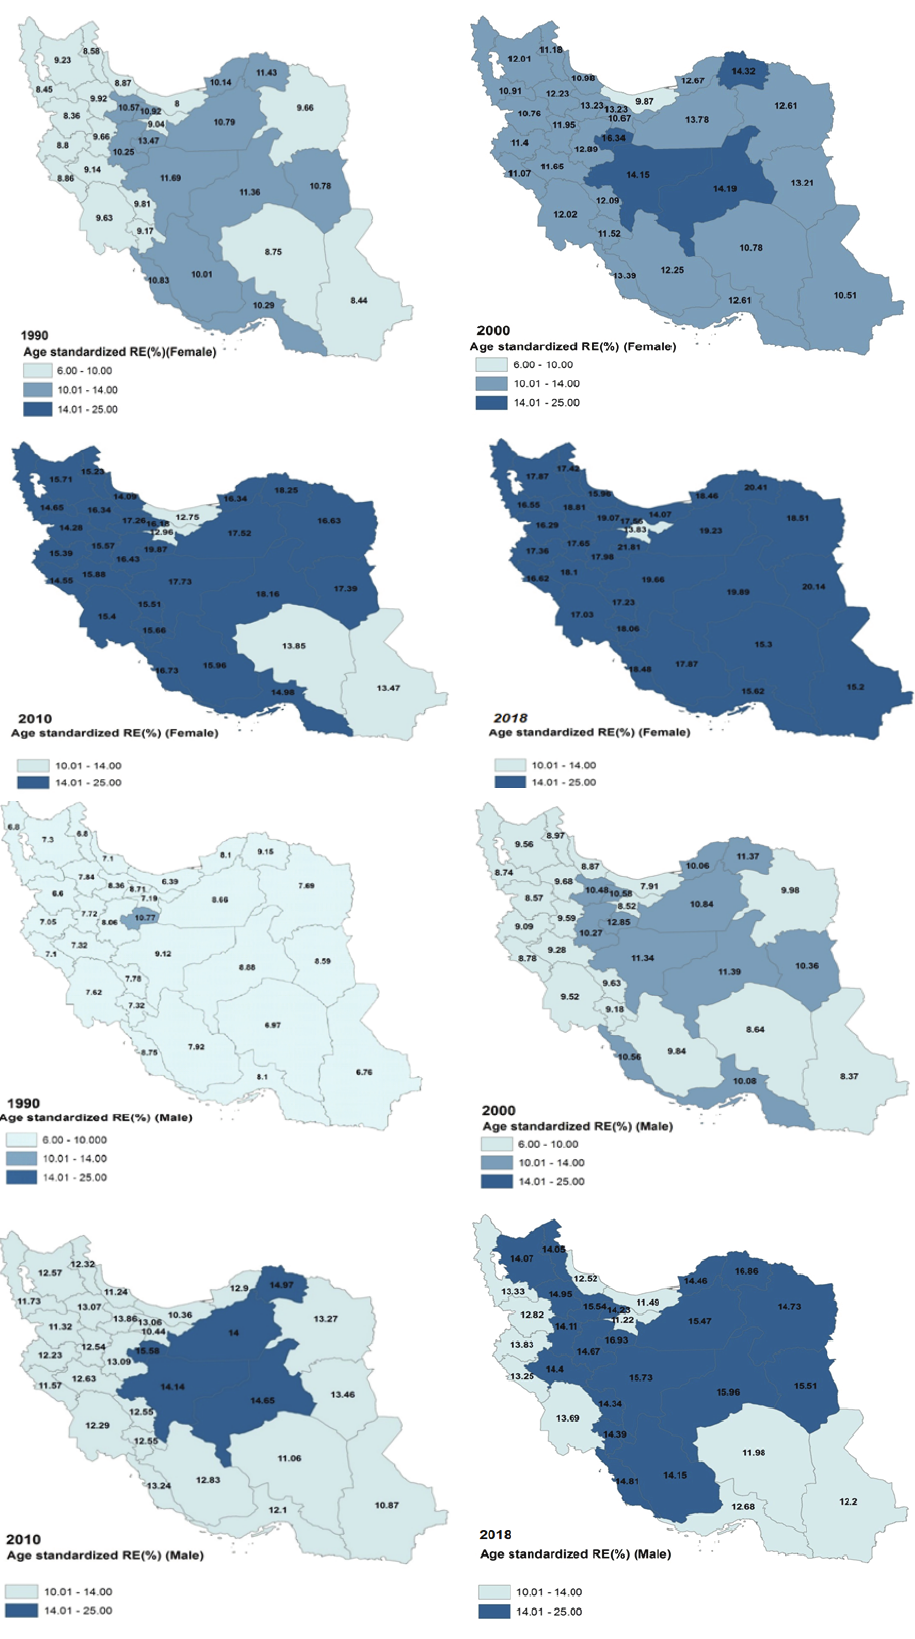
Figure 4. Geographic distribution of age-standardized prevalence in different years (a: Females, b: